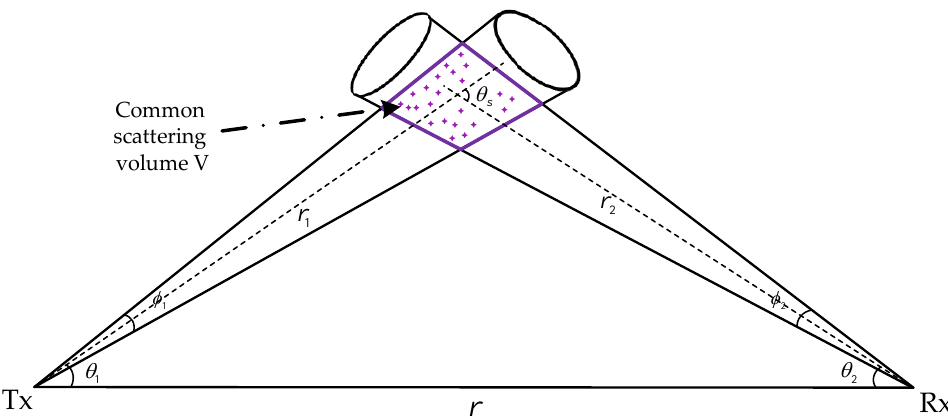
Figure 1. NLOS single scattering communication geometry.